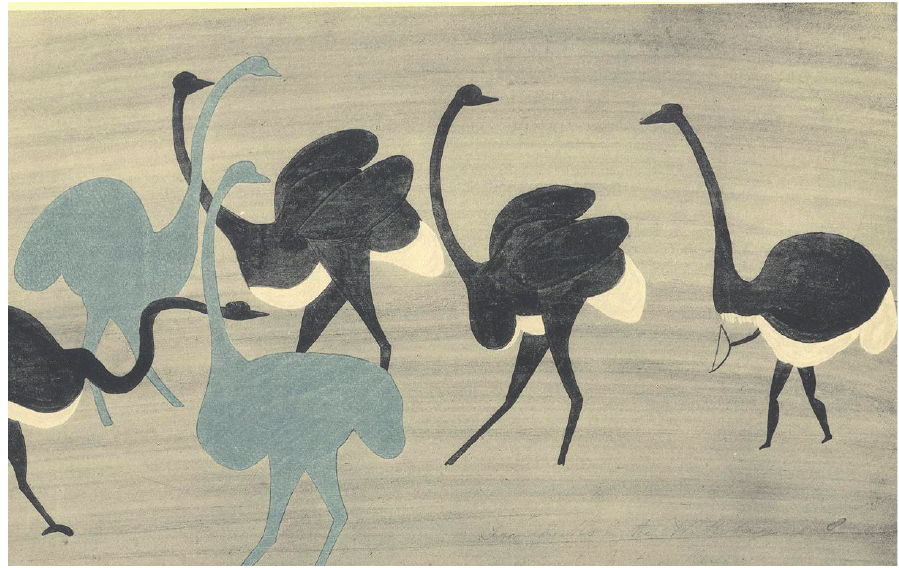
Illustration 3. Ostrich hunt. Source: Stow and Bleek (1930), Plate